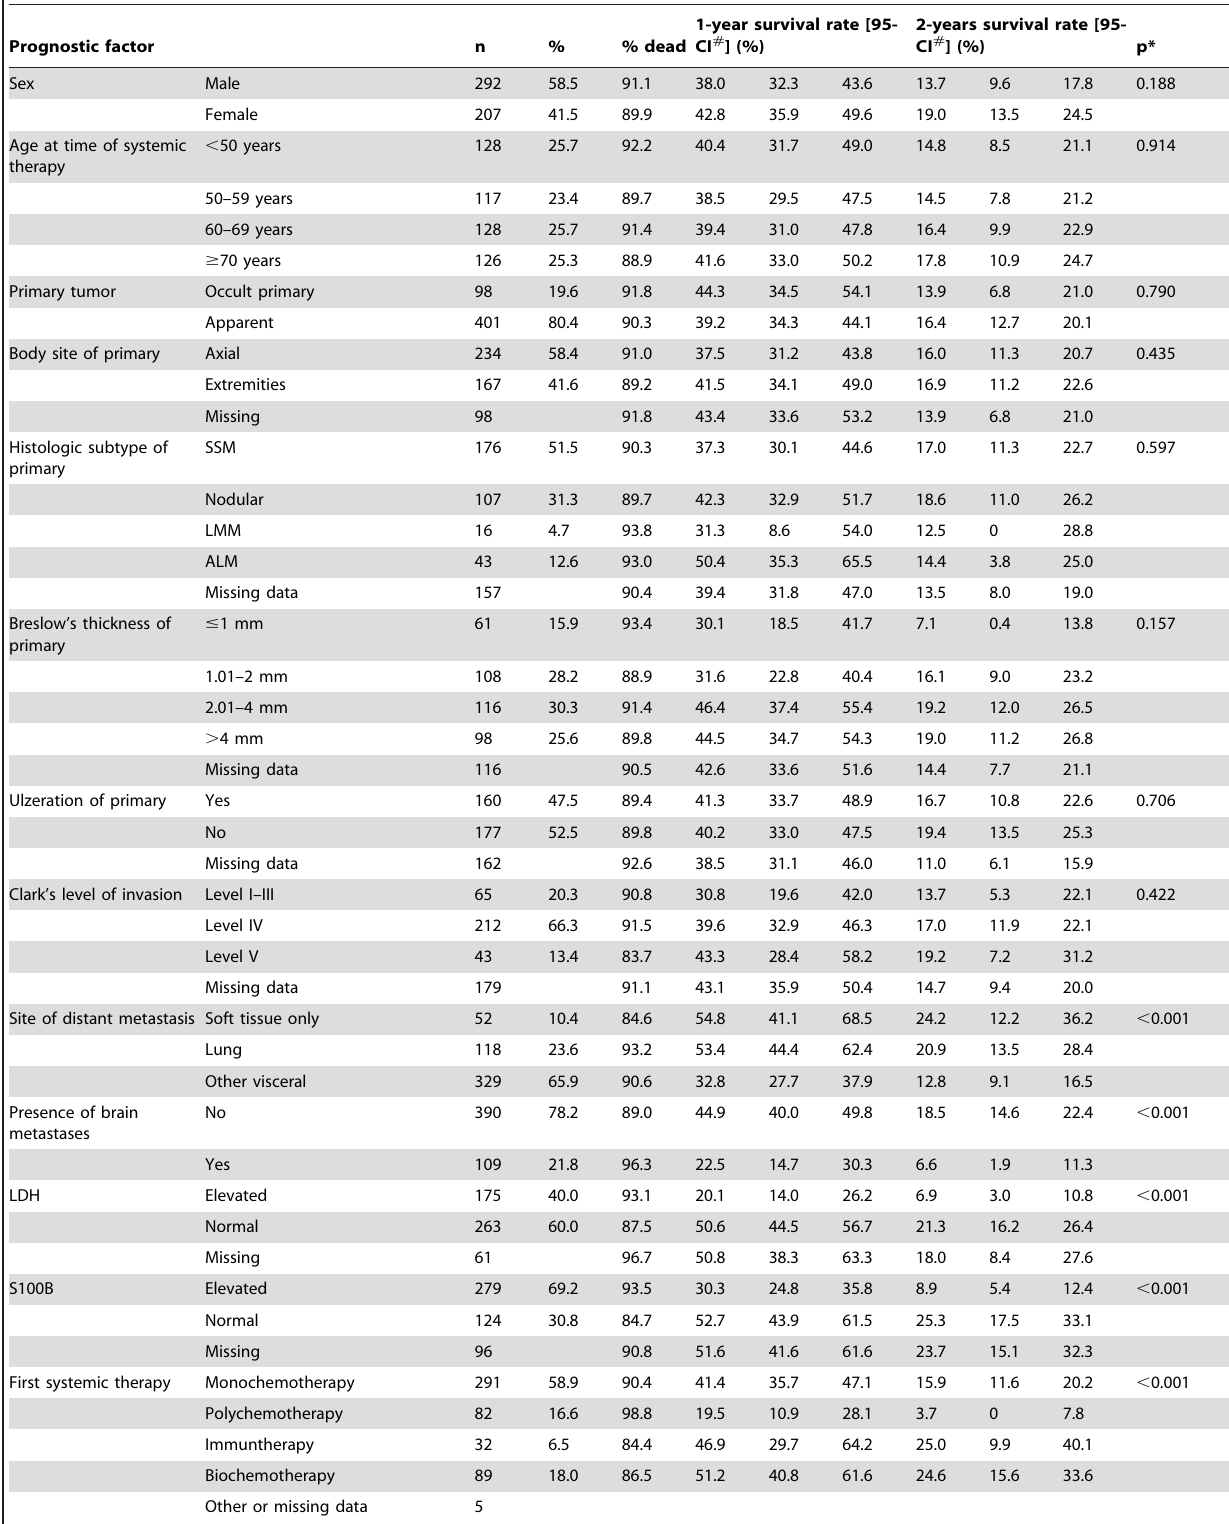
Table 1. Descriptive statistics and survival rates according to